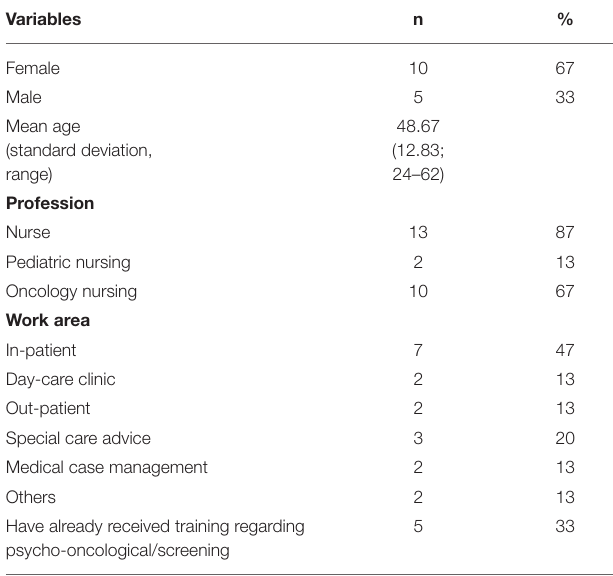
TABLE 1 | Demographic data of the interview